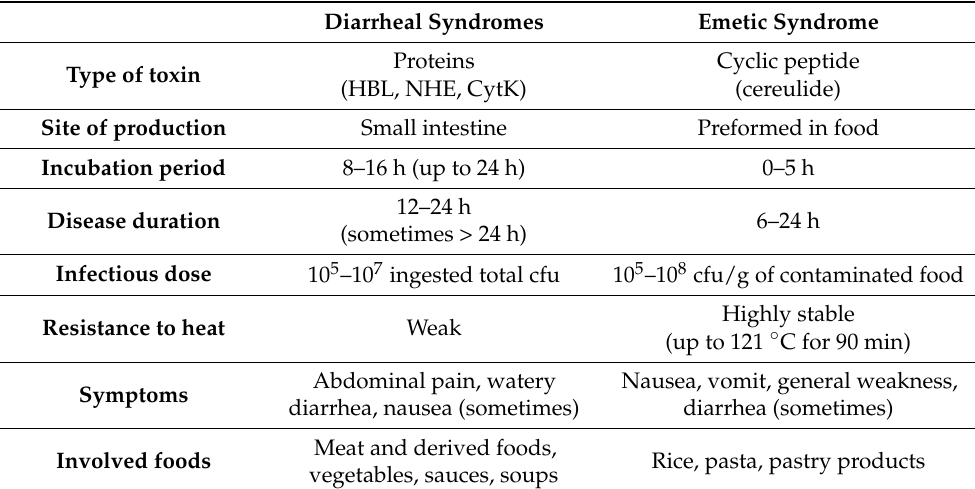
Table 1. General traits of the diarrheal and emetic syndromes caused by B. cereus . Diarrheal Syndromes Emetic Syndrome Type of toxin